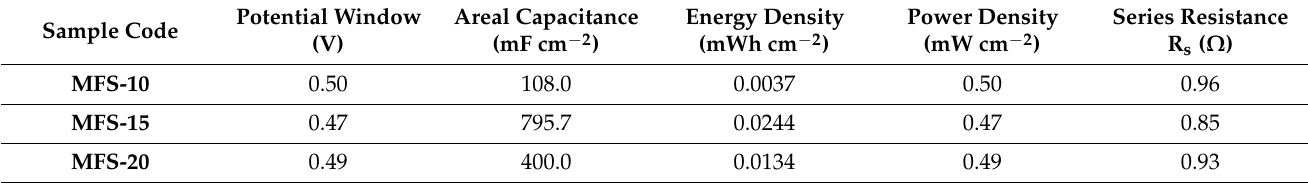
Table 1. Comparative table of areal capacitance, energy density, and power density and series resistance of Mn–Fe–S electrodes along with sample codes and applied potential window.